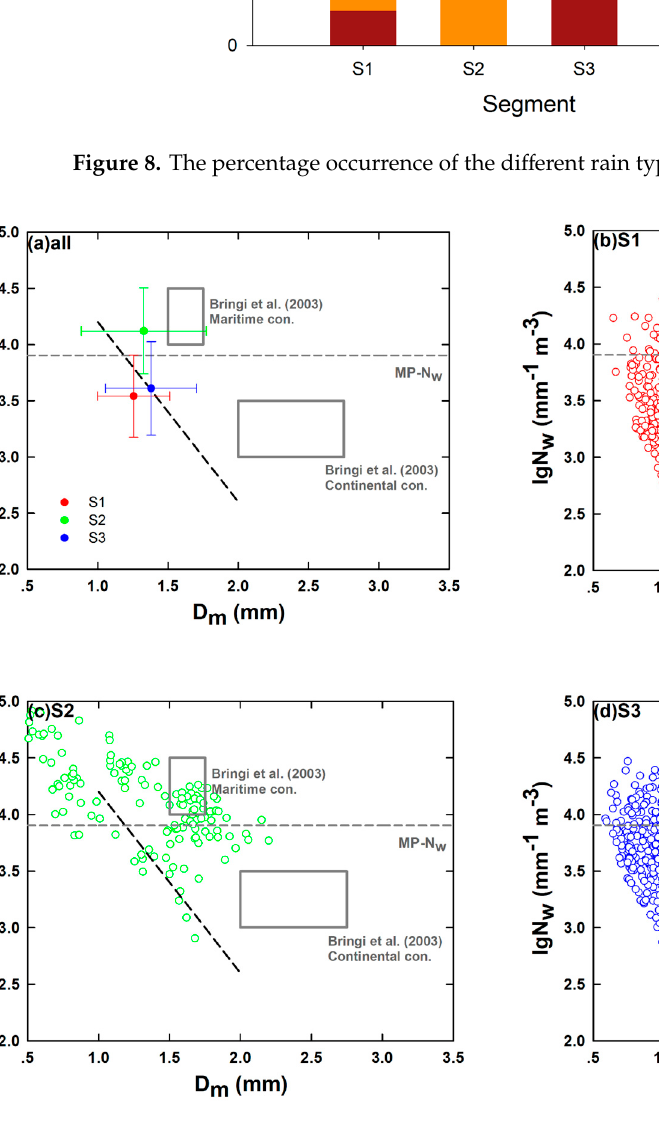
Figure 9. ( a ) The mean and variance of the mass-weighted mean diameter D m (mm) and the generalized number concentration N w (mm − 1 m − 3 ) for the entire dataset. Scatterplot of D m and N w ( b ) during S1, ( c ) during S2, and ( d ) during S3. The black dotted line is the regression relationship of Bringi et al. (2003) for stratiform rain. The two gray rectangles are the maritime-like and continental-like clusters of Bringi et al. (2003).